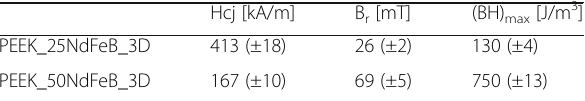
Table 13 Magnetic properties of the printed samples